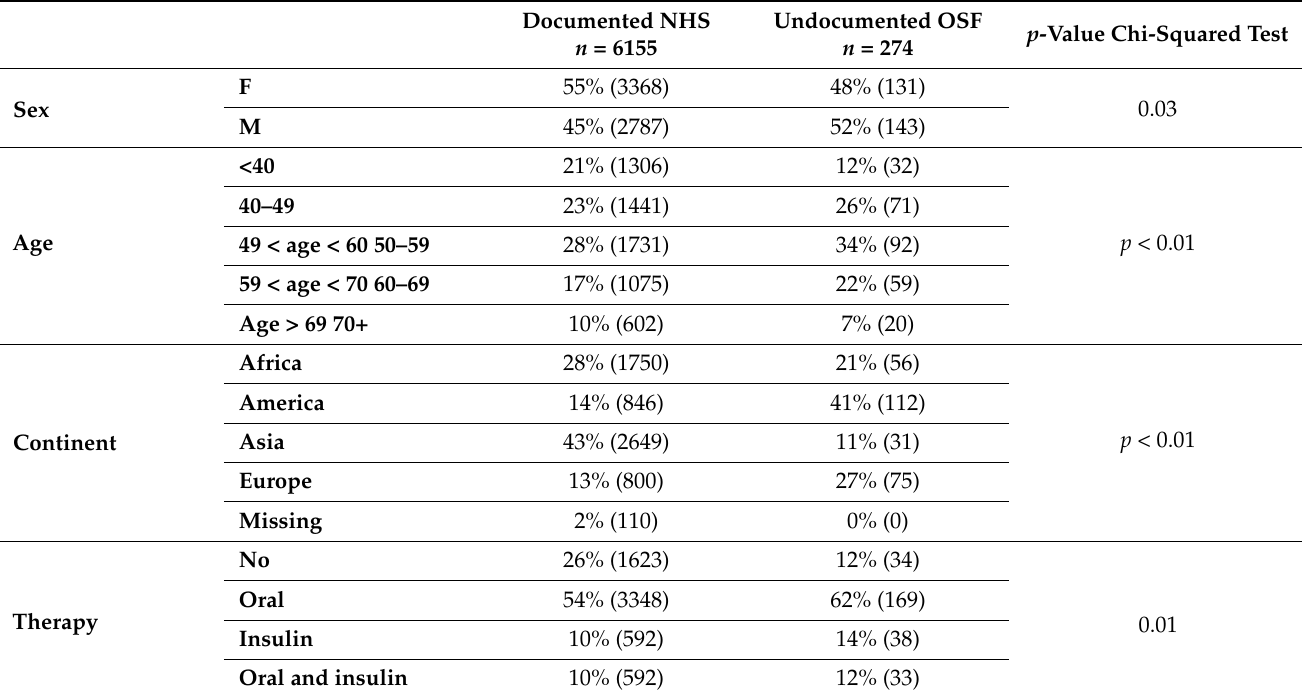
Table 1. Characteristics of the